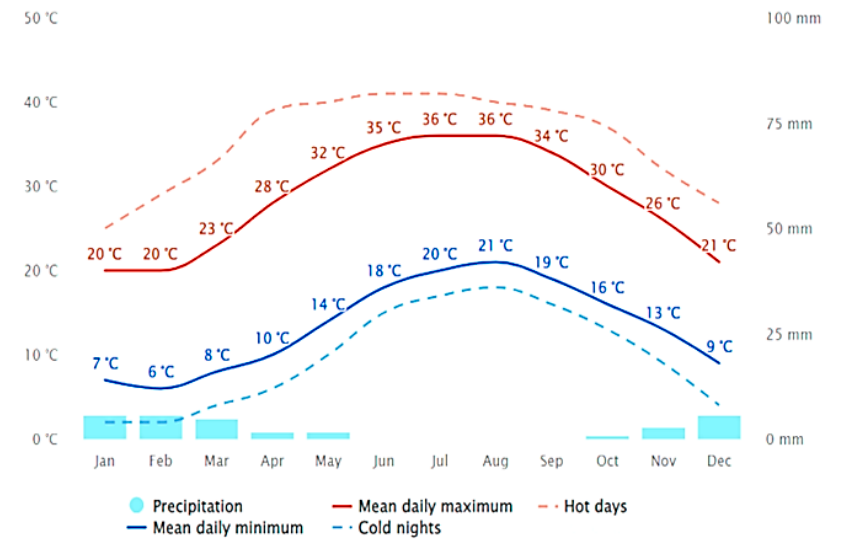
Figure 2. Climate parameters of the studied area.